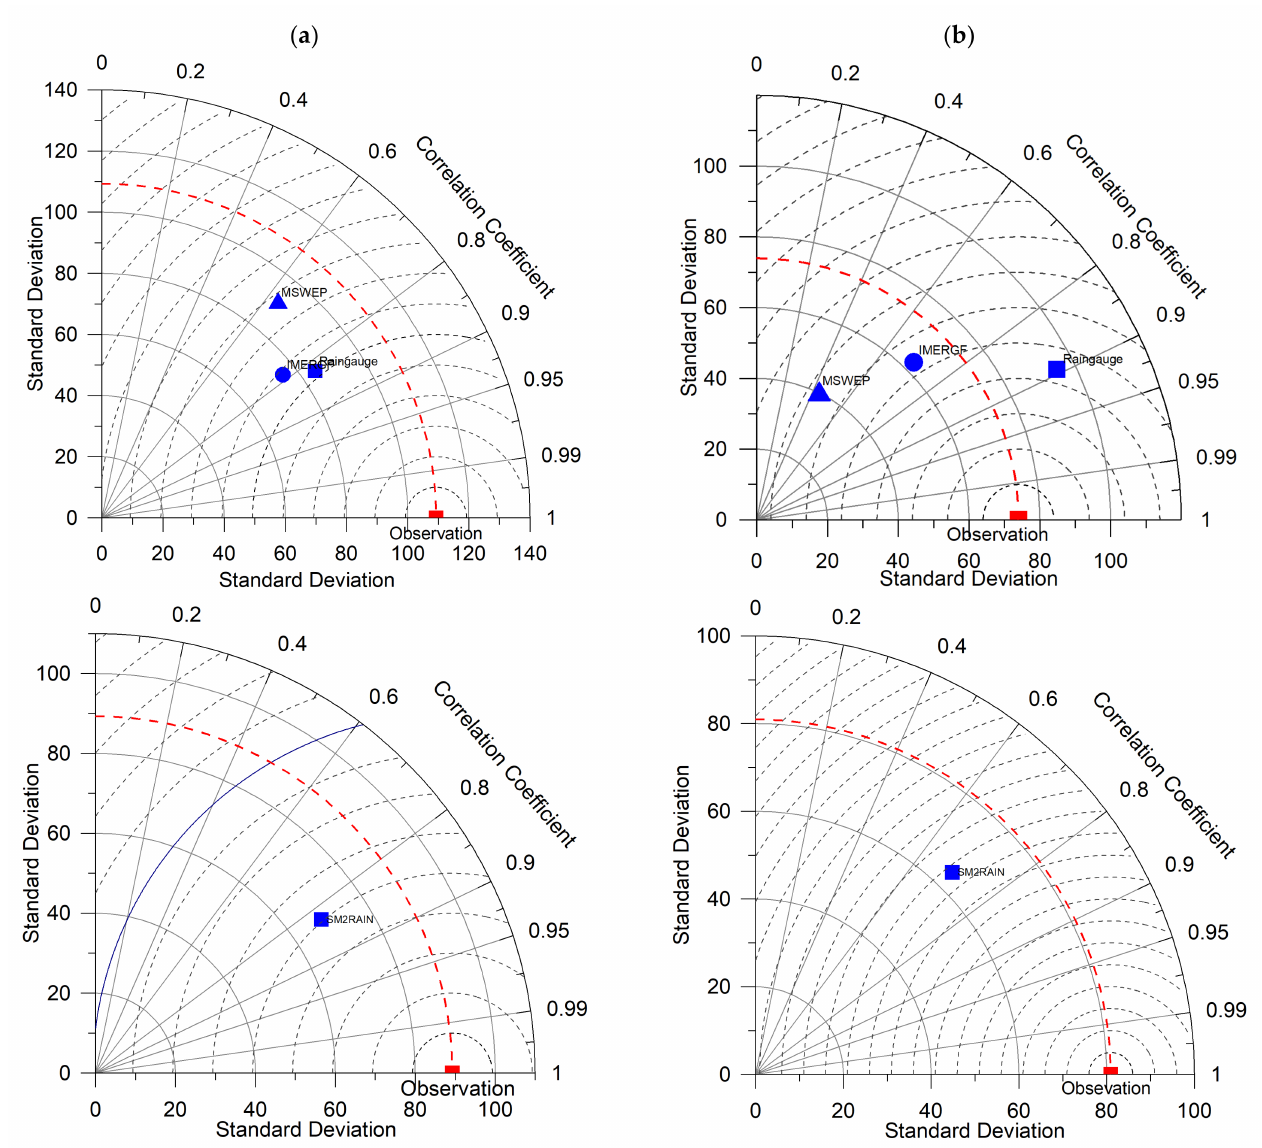
Figure 10. Taylor diagrams showing the correlation between observed and simulated streamflow for ( a ) calibration and ( b )